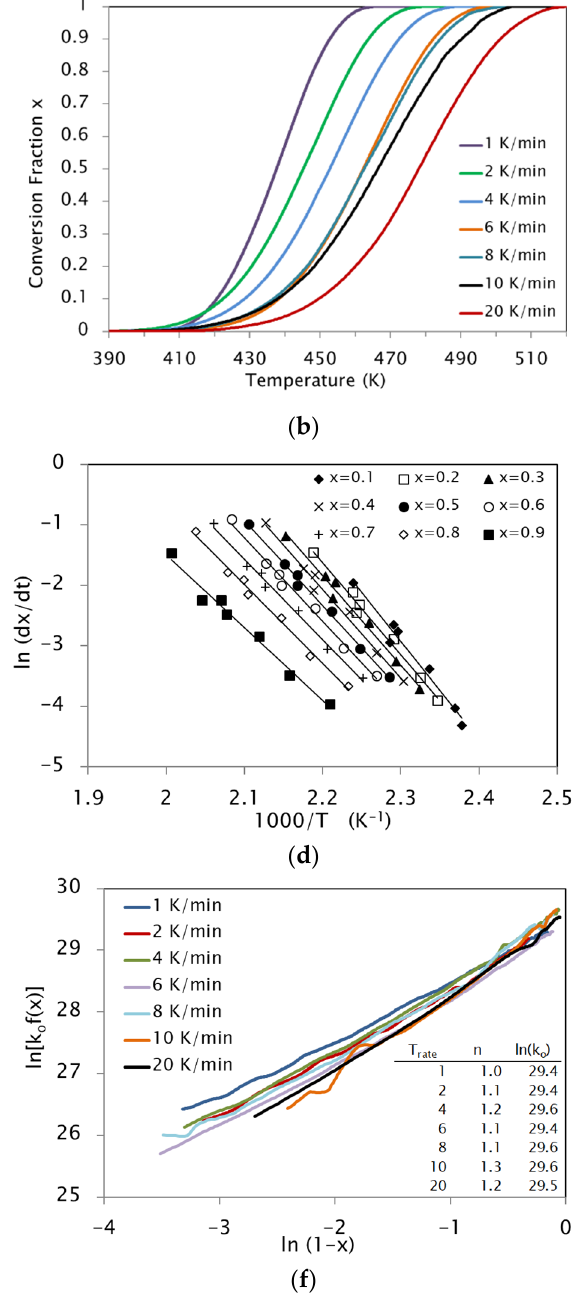
Figure 5. ( a ) (𝑑𝑥 𝑑𝑡⁄ ) curves, corresponding to DSC curves of P 2 after baseline correction, recorded during heating Cu 5 samples quenched from 970 K, at different rates β i = 1–20 K/min; ( b ) normalized integrals giving the x ( T ) curves for the different β i ; application of the Kissinger − Akihara − Sunose method ( c ), and Friedman’s method ( d ); ( e ) apparent activation energies as a function of x obtained after those methods; ( f ) plots of (cid:4670)𝑙𝑛(𝑑𝑥 𝑑𝑡⁄ ) + (𝐸 (cid:3028)(cid:3030) 𝑅𝑇⁄ )(cid:4671) vs.𝑙𝑛(1 − 𝑥) for each β i using E ac = 1.2 eV, yielding the values of n and ln( k o ) given in the inset.